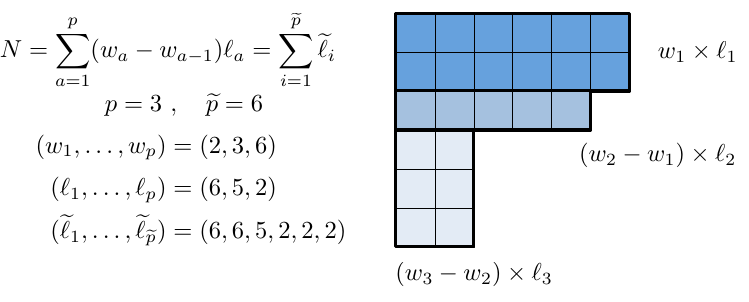
‘ i . We highlighted the decom- a , w a 1 ) (cid:2) ‘ a (cid:0) (cid:0) e